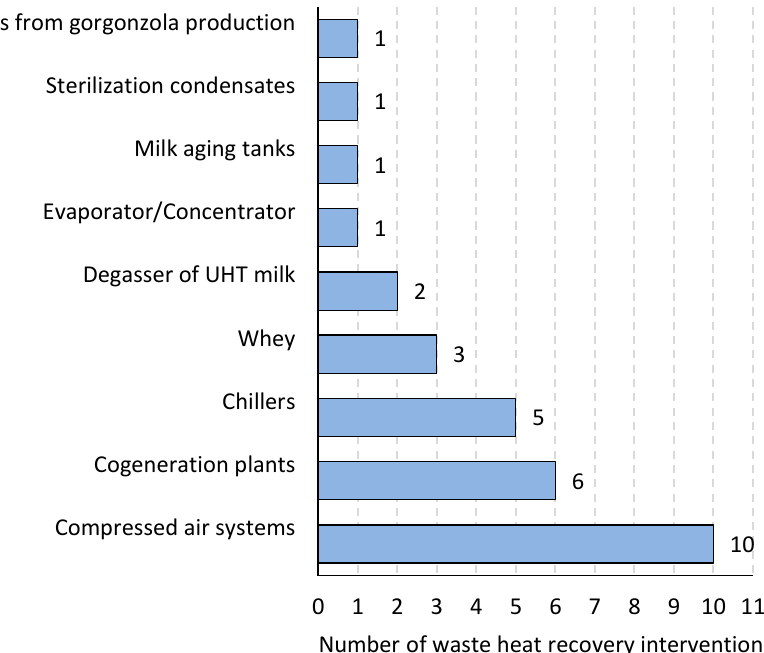
Figure 6. Number and type of waste heat recovery interventions.